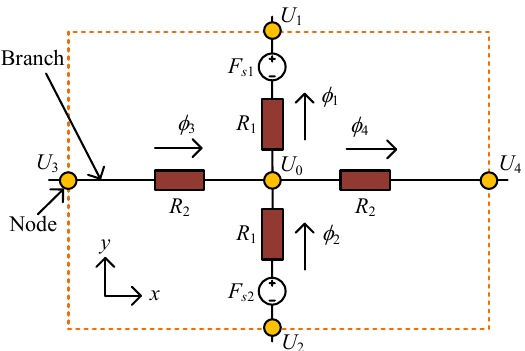
Figure 3. Structure of a reluctance mesh element and MMF source